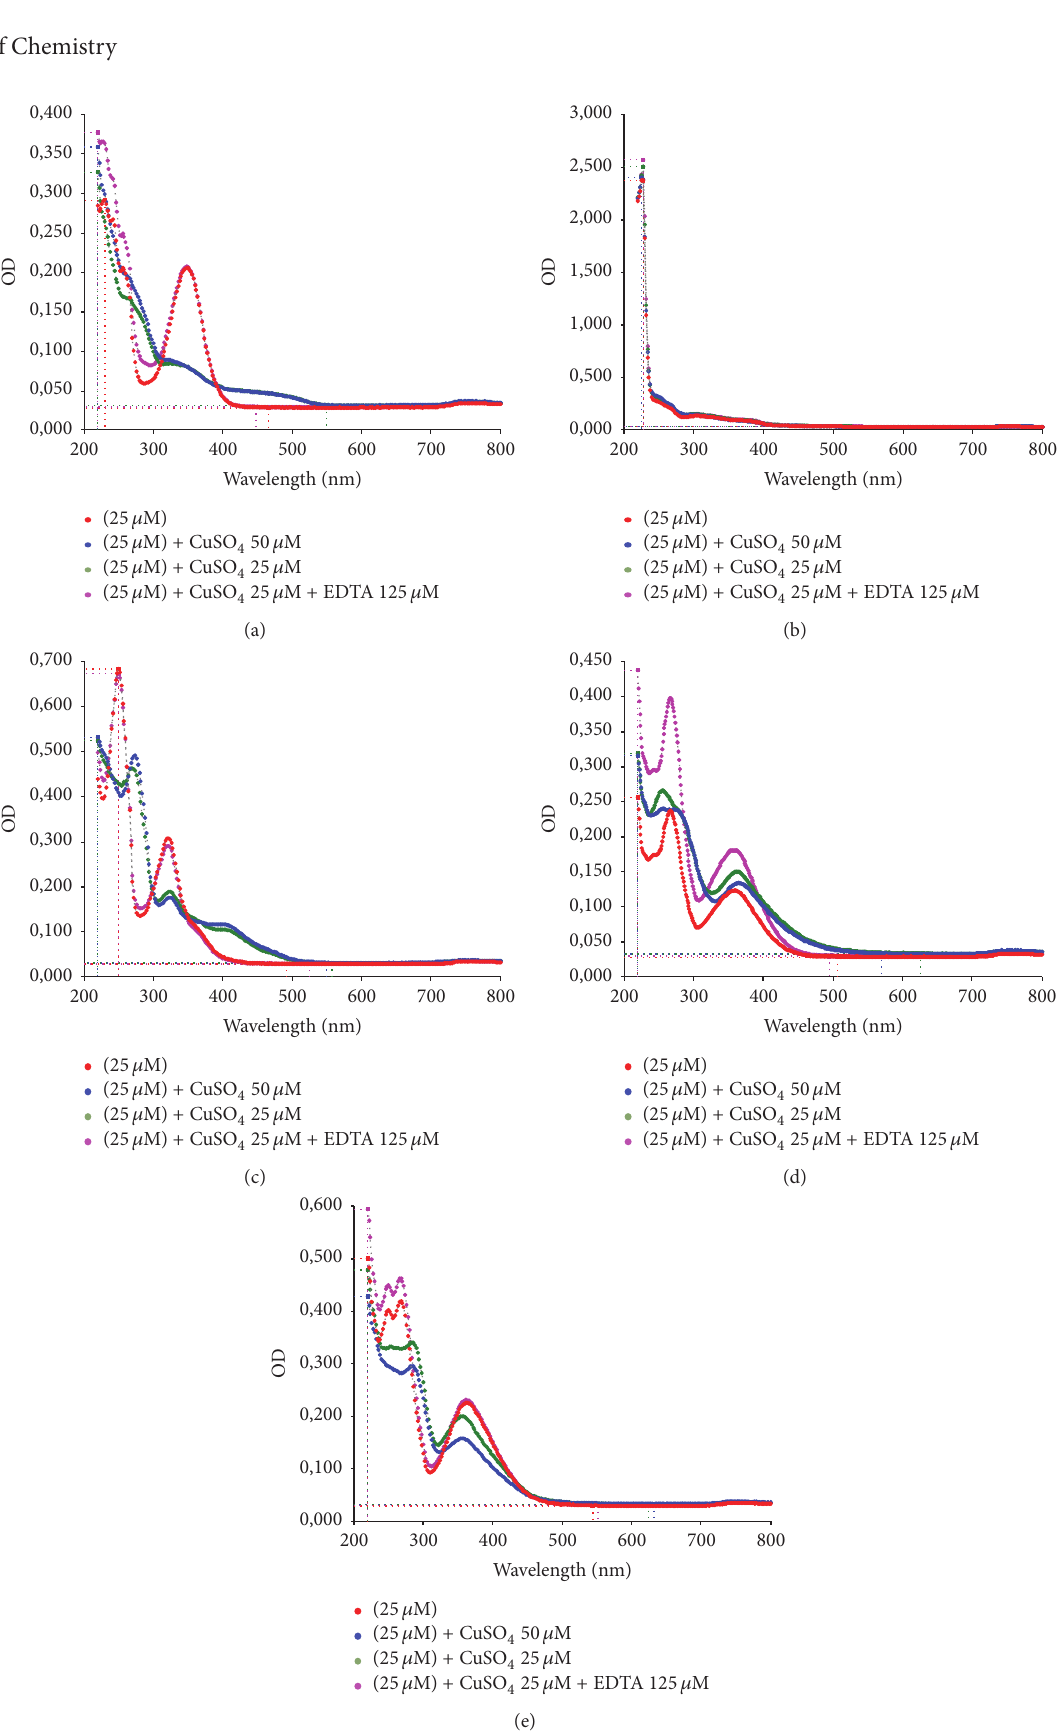
Figure 1: UV-Vis spectra of 25 𝜇 M of compounds 1 (a), 2 (b), 3 (c), 13 (d), and 14 (e) in PBS at pH 7.4 (red spectra), after the addition of 25 𝜇 M CuSO 4 (green spectra), 50 𝜇 M CuSO 4 (blue spectra), and 25 𝜇 M of CuSO 4 plus 125 𝜇 M of EDTA (pink